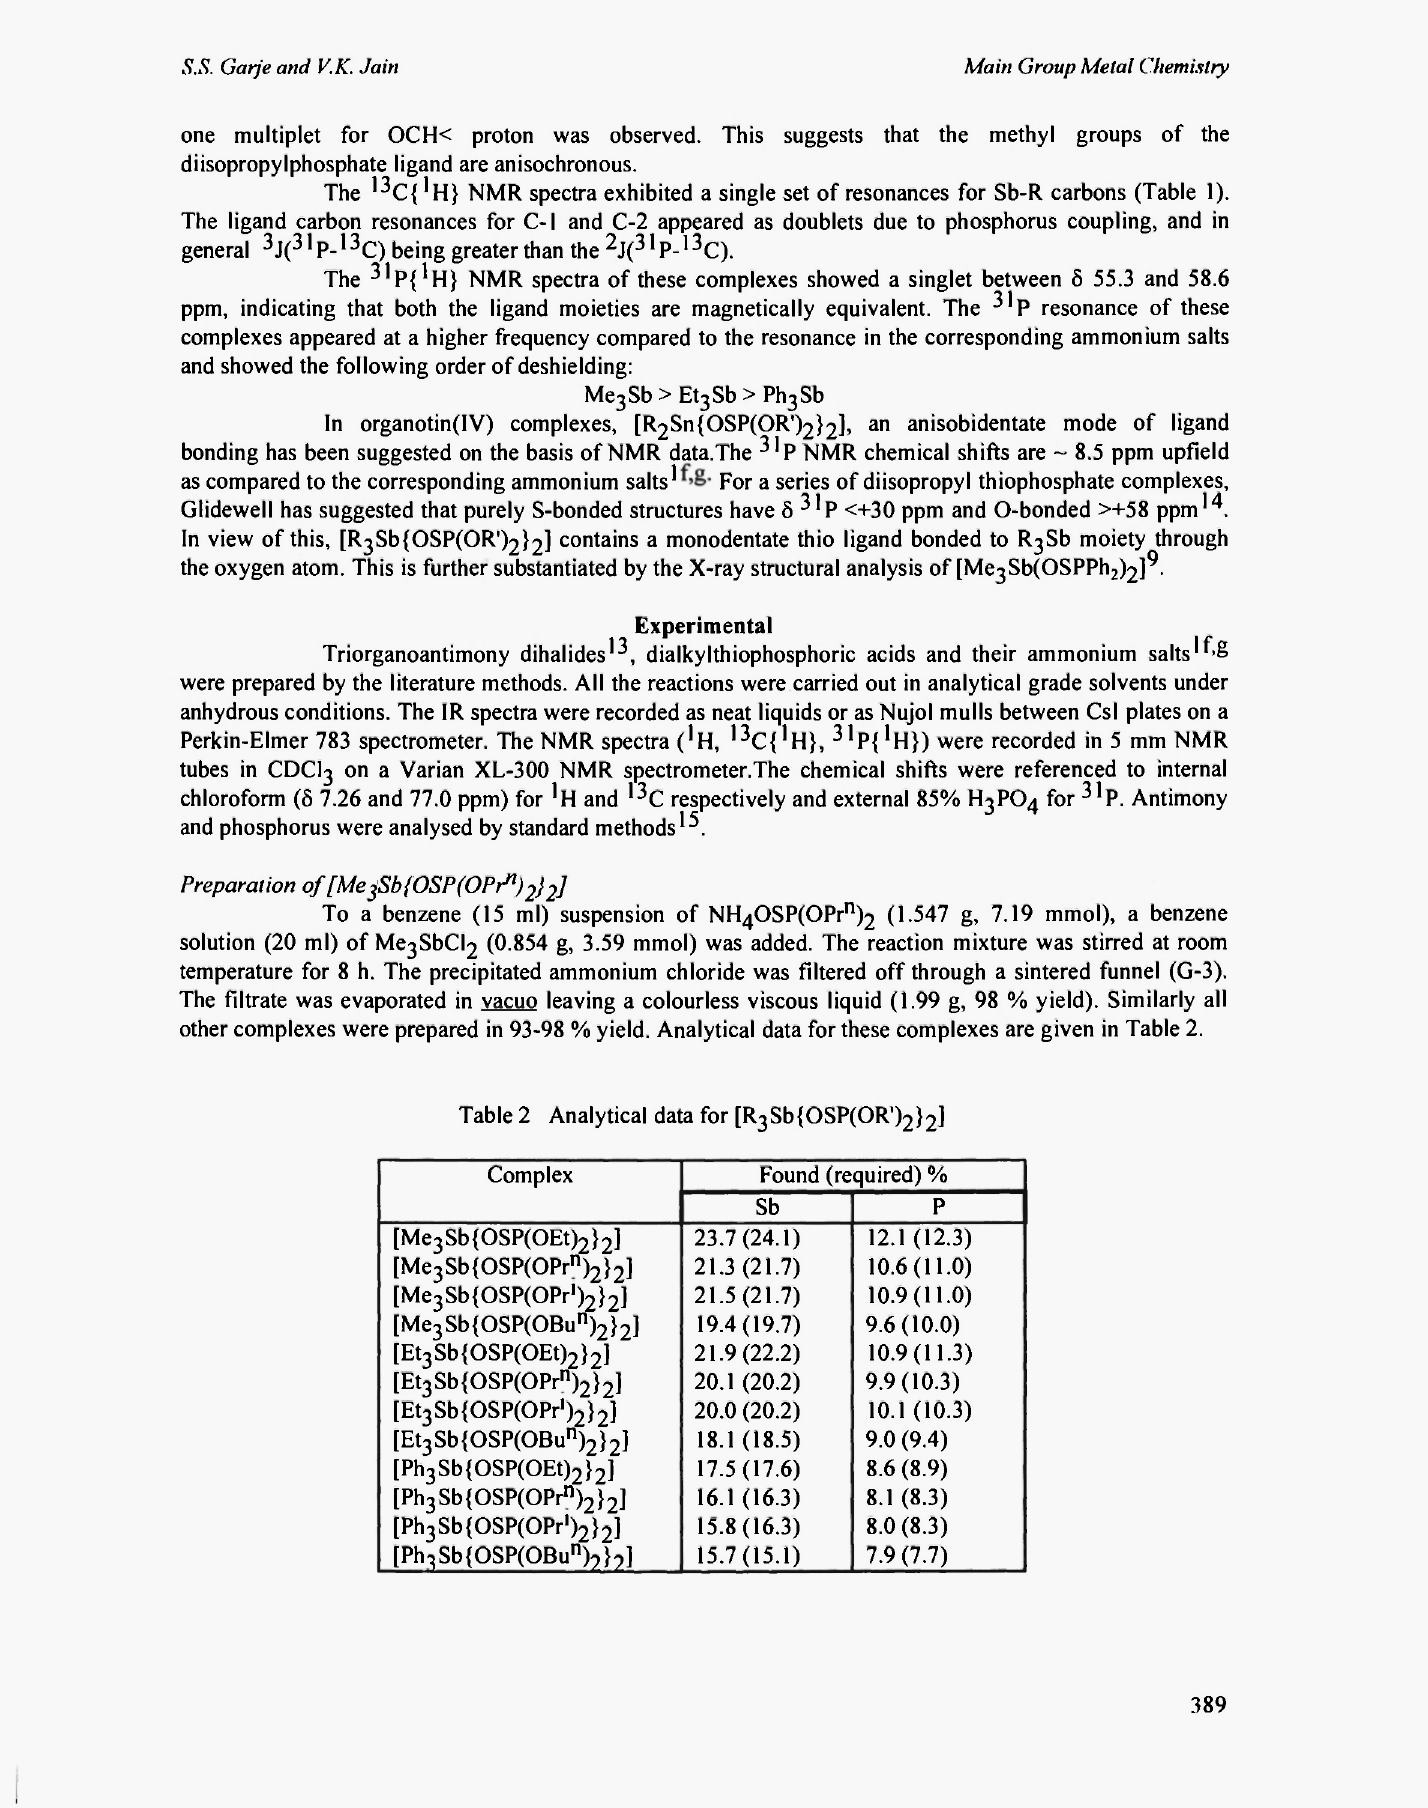
Table 2 Analytical data for [R 3 Sb{OSP(OR') 2